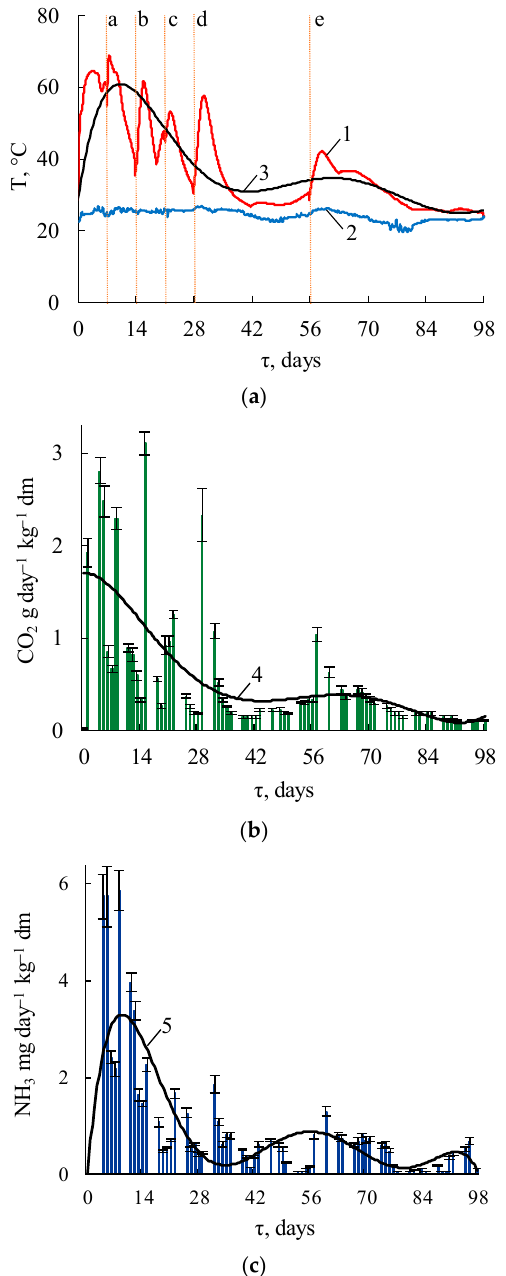
Figure 1. The temperature regime and gaseous emissions. ( a ) temperature: 1—substrate; 2—ambient; 3—approximation of the substrate temperature (R 2 = 0.67 p < 0.05); a–e—stirring and moistening; ( b ) СО 2 emission: 4—approximation (R 2 = 0.4 p < 0.05); ( c ) NH 3 emission: 5—approximation (R 2 = 0.54 p < 0.05).